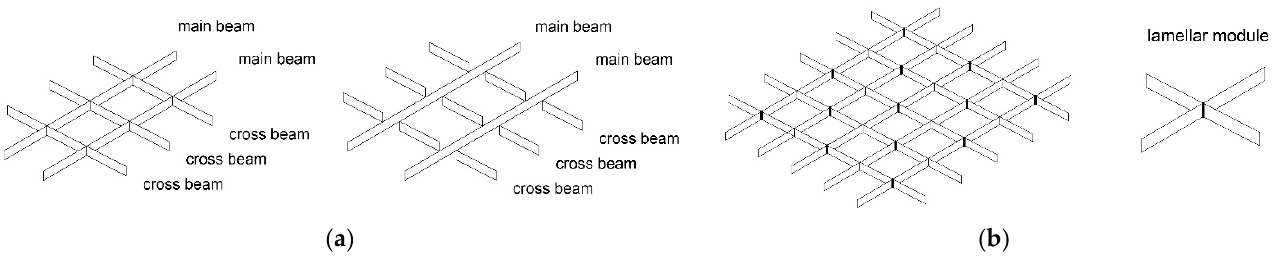
Figure 23. Arrangement of beams in the grillage: ( a ) hierarchy of beams; ( b ) lamellar system (figures by the author).